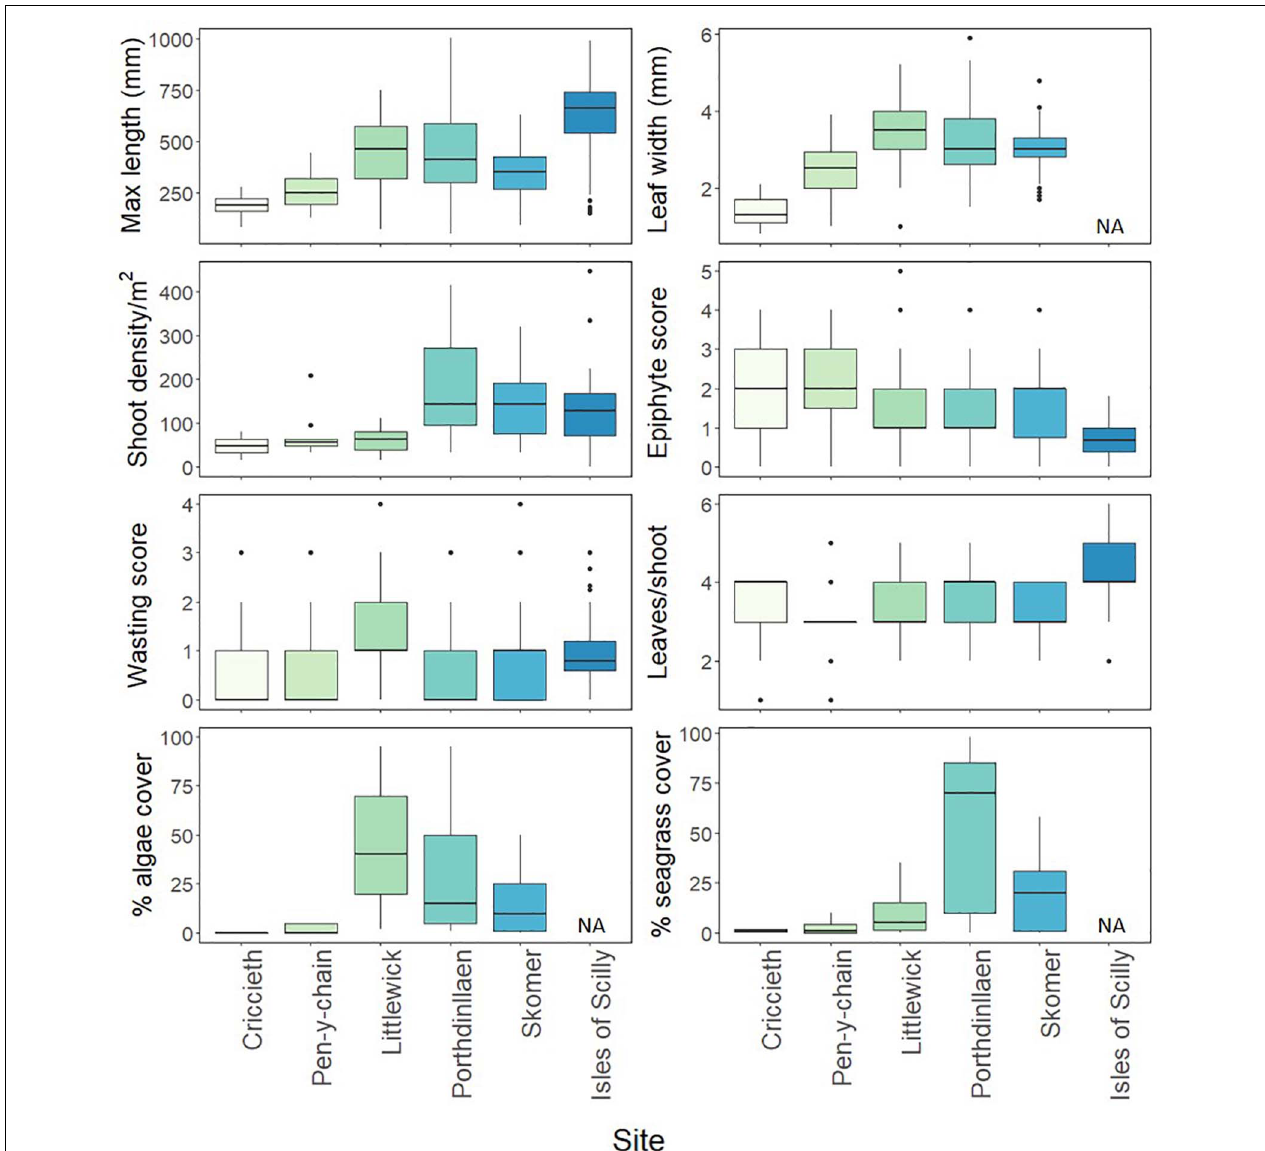
FIGURE 2 | Seagrass shoot and meadow characteristics measured at different seagrass sites. The box-whisker represents the median (line) and interquartile range (box) with additional 1.5 × interquartile range shown as whisker. Outliers are shown as points outside the box-whisker plots. Algae and seagrass cover taken from drop-down camera footage of quadrats taken at each site except Isles of Scilly ( n ≥ 40 per meadow except Criccieth where n = 12 due to poor